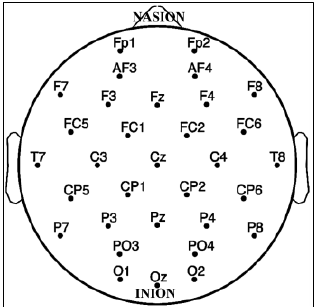
Figure 2. The positioning of the 32 channels on the scalp is based on the System 10-20 International